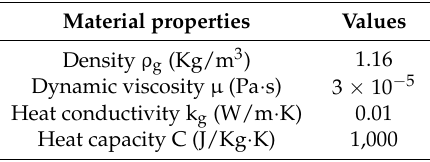
Table 2. Material properties of pyrolysis